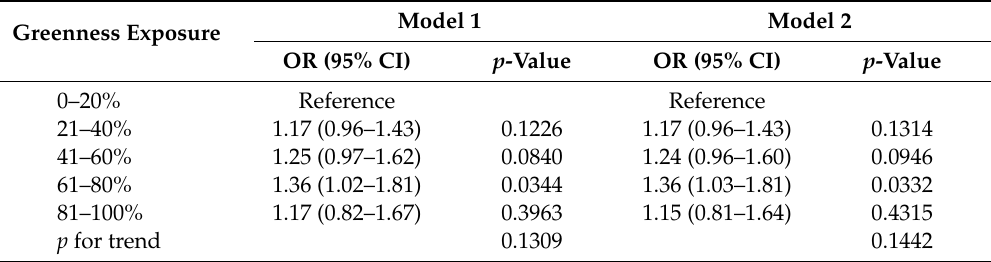
Table 4. The odds ratios (OR) and 95% confidence intervals (CIs) of asthma occurrence according to the level of greenness exposure in subjects from 6 to 17 years